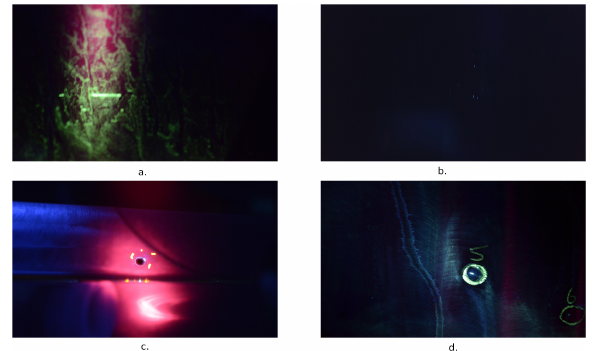
Figure 5. Images from the dataset ( a ) Image with green areas, ( b ) Image without green areas, ( c , d ) Images with possible